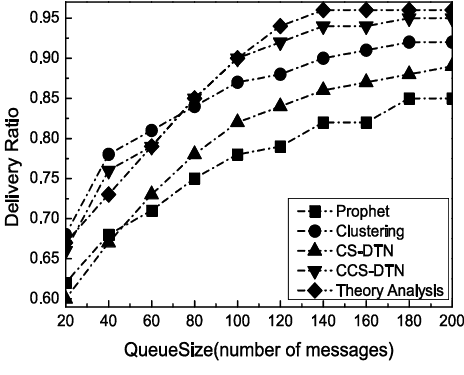
Figure 5. Impact of Queue Size on Delivery